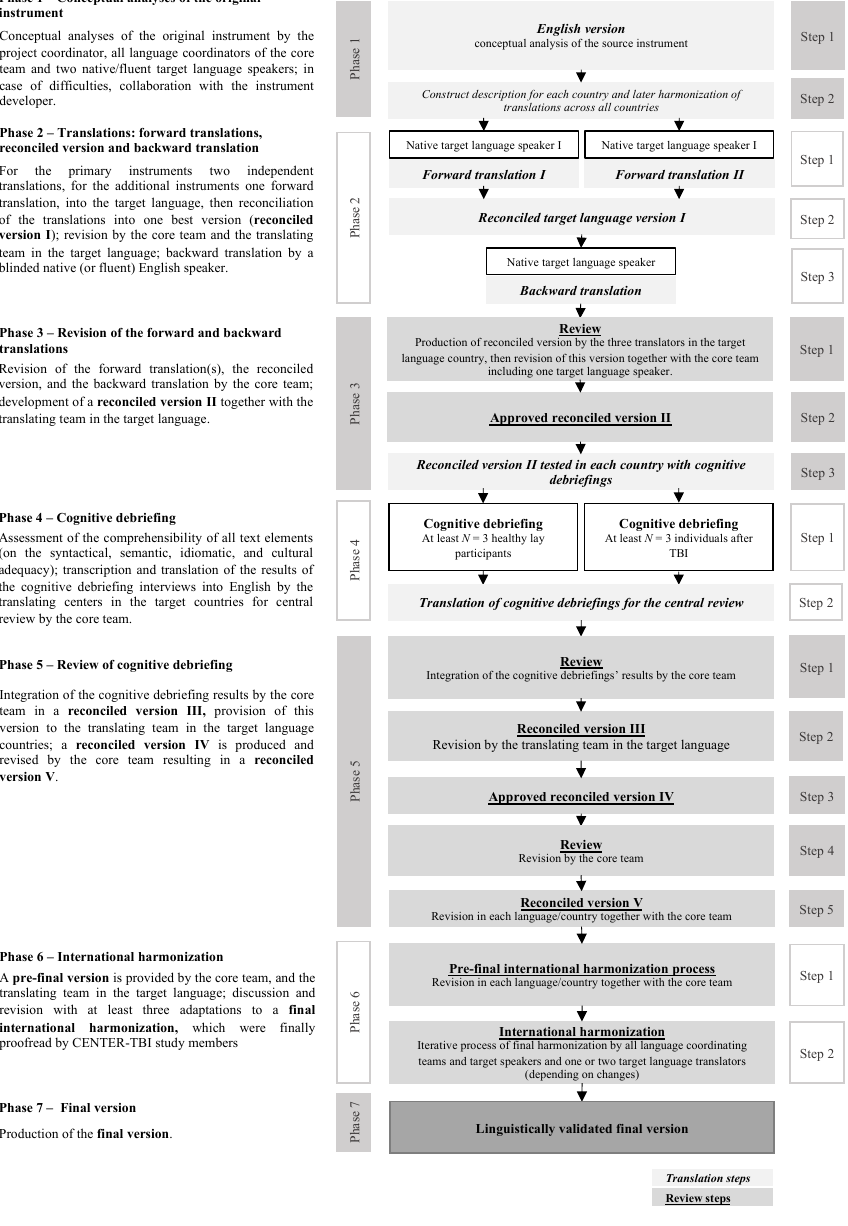
Figure 1. Translation and linguistic validation process.